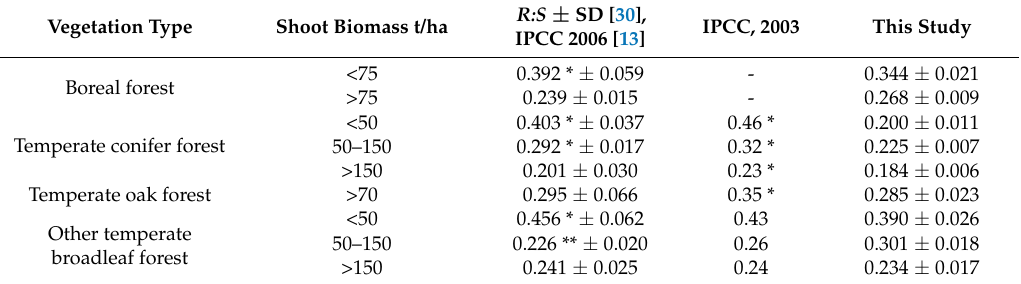
Table 5. Comparison of the root-to-shoot estimates calculated using our approach with other published values. Vegetation